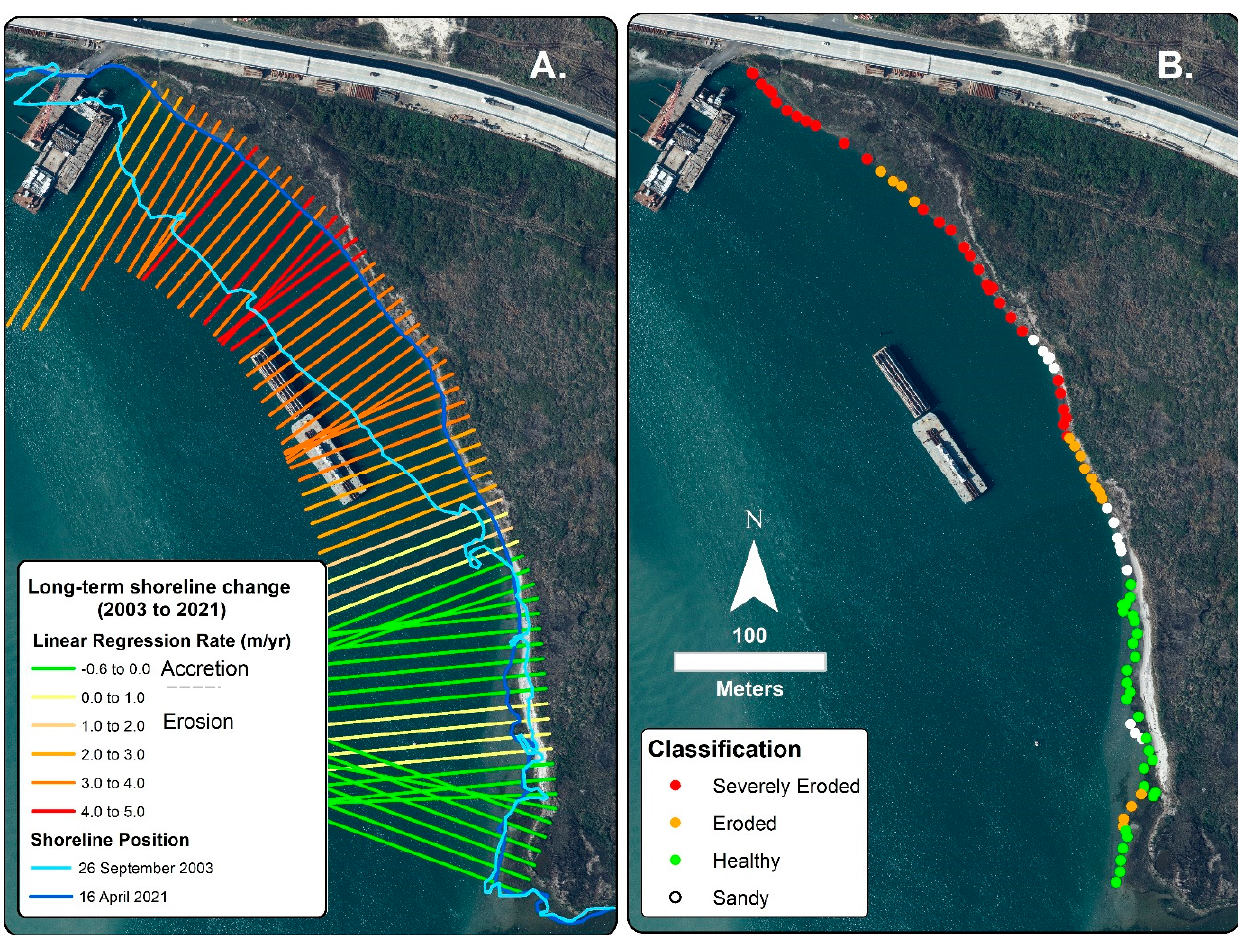
Figure 2. ( A ) Long ‐ term shoreline change rate (m/year) at each transect (shore ‐ perpendicular green ‐ to ‐ red lines), determined using bimonthly aerial imagery. The 26 September 2003 shoreline position (light blue) and 16 April 2021 shoreline position (darker blue) are shown to illustrate the severity of ongoing erosion in the study area. ( B ) The 3 May 2021 shoreline classification shows severely eroded, eroded, healthy, and sandy shorelines.